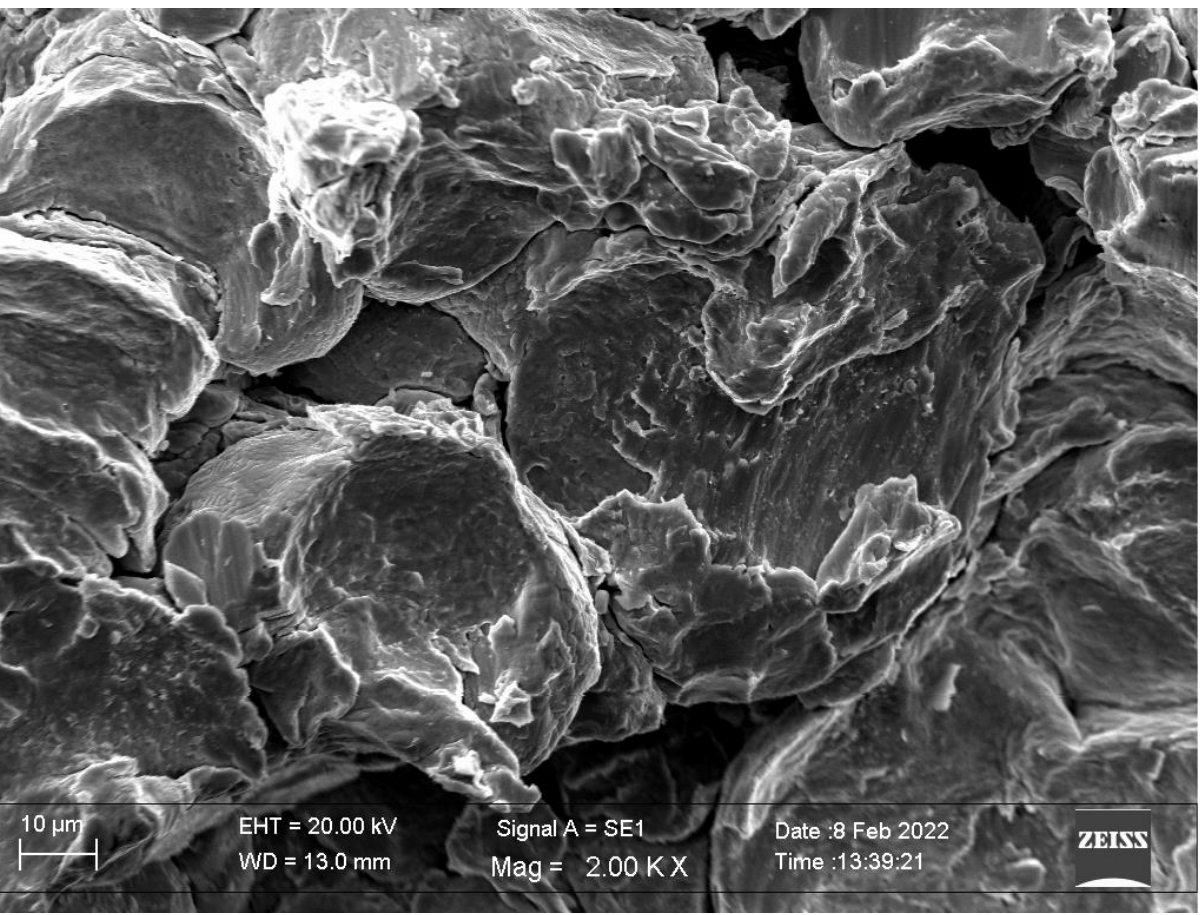
Figure 15. Local fatigue mechanisms observed on single particles after fracture.